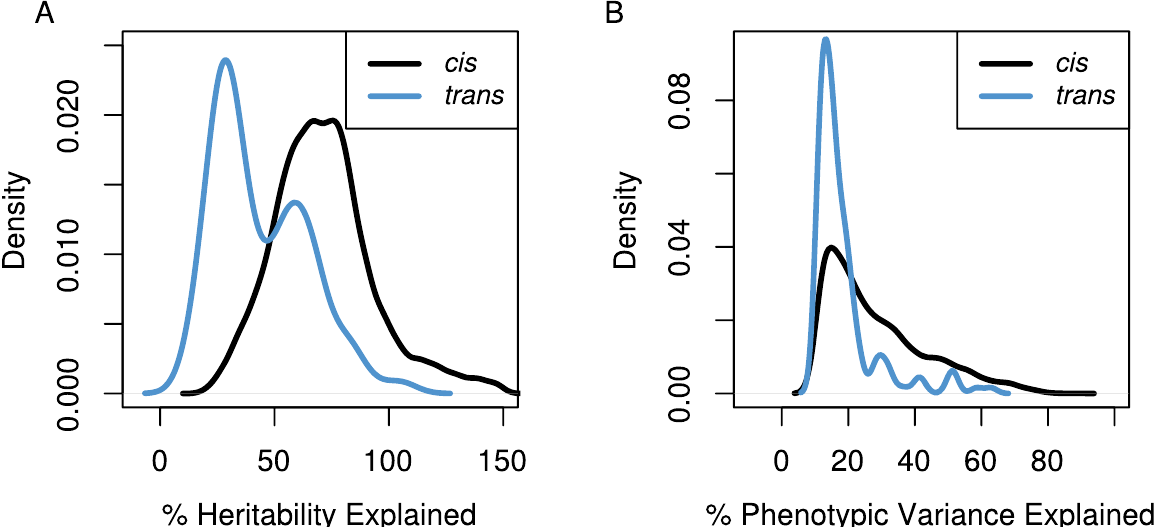
Figure 2. The distributions of the percentage of the genetic variation (A) and phenotypic variation (B) explained for cis - (black line) and trans - (blue line) eQTL. Estimates of the percentage of genetic variance explained can be greater than 100% due to underestimates of heritability for transcripts and/or overestimates of effect sizes of eQTL.